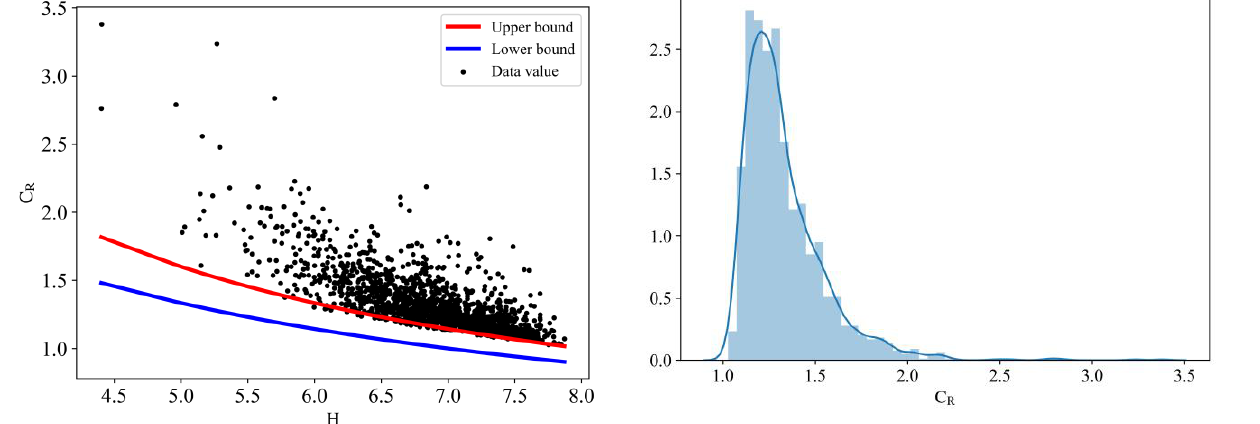
Figure 9. Theoretical bounds of Shannon’s theorem and the scatter plot of H against C R obtained by Deflate To further decipher the distribution pattern of compression ratio obtained by LZMA, JEPG-LS and Deflate, Kernel Density Estimation (KDE) (Terrell, Scott, 1992, Botev et al. 2010) is employed here. Three such plots are shown in Figure 10, Figure 11 and Figure 12. Indeed, most compression ratio values are located within an interval, i.e., 1.0 to 2.5. This is due to the range